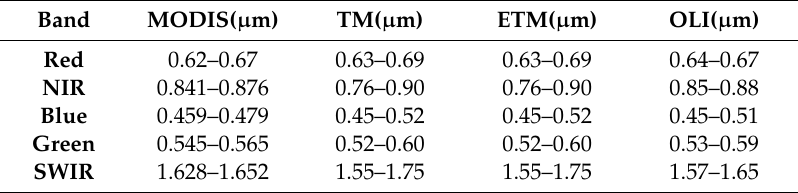
Table 1. Comparison of band width among di ff erent